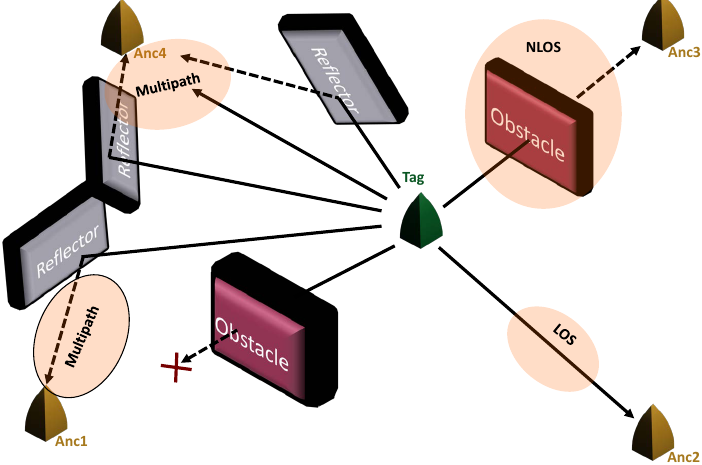
Figure 1. Illustration of LOS, NLOS and multi-path (MP) scenarios in a UWB-based ranging